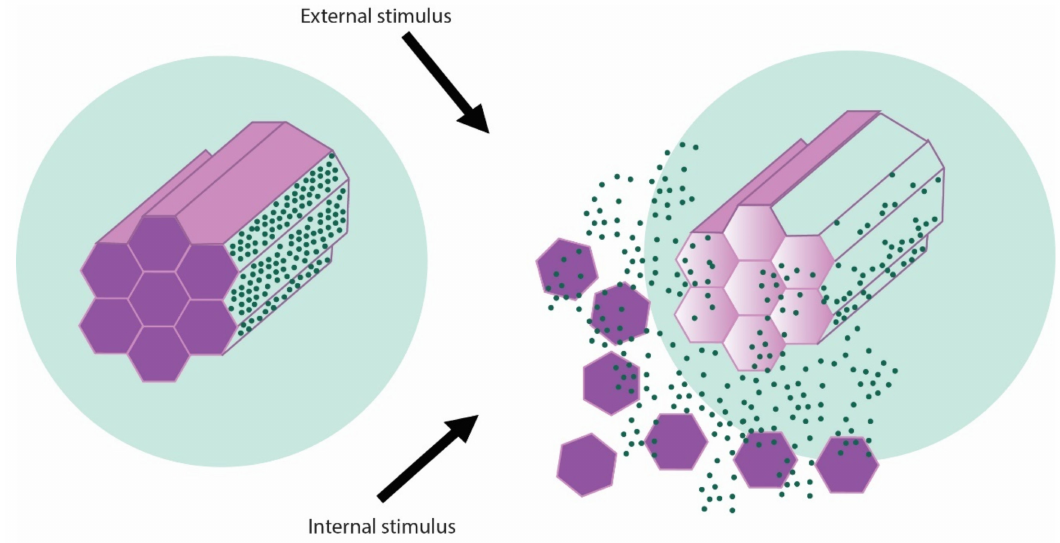
Figure 2. Schematic representation of stimuli-generated release of therapeutic cargo from